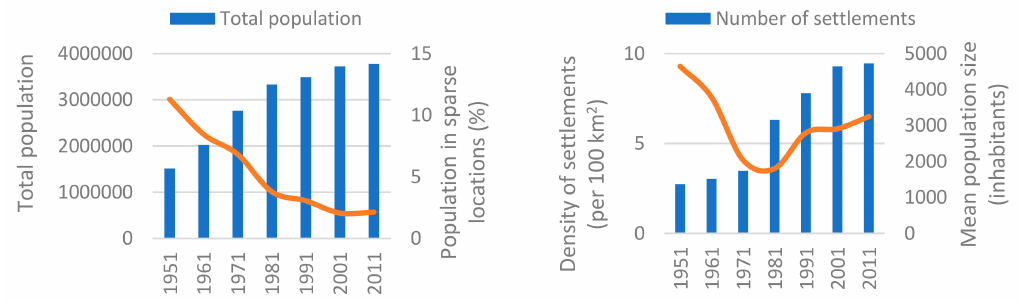
Figure 4. Total population and the percent share of population residing in sparse locations in total population in the study area ( left ); density of settlements (excluding urban centers) and the relative mean population size (inhabitants) by year ( right ).